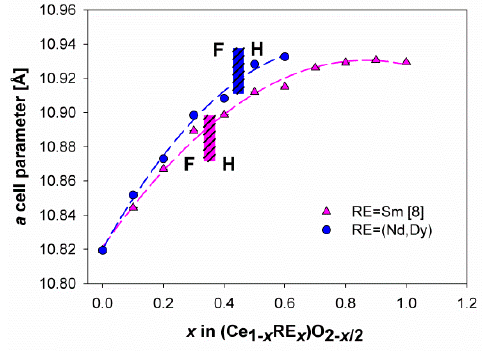
Figure 5. Trend of the lattice parameter of the Nd/Dy- and Sm-doped systems as a function of the doping ion(s) content. Data of Sm are taken from Reference [8]. Error bars are hidden by data markers. Data are fitted by second order polynomial functions.